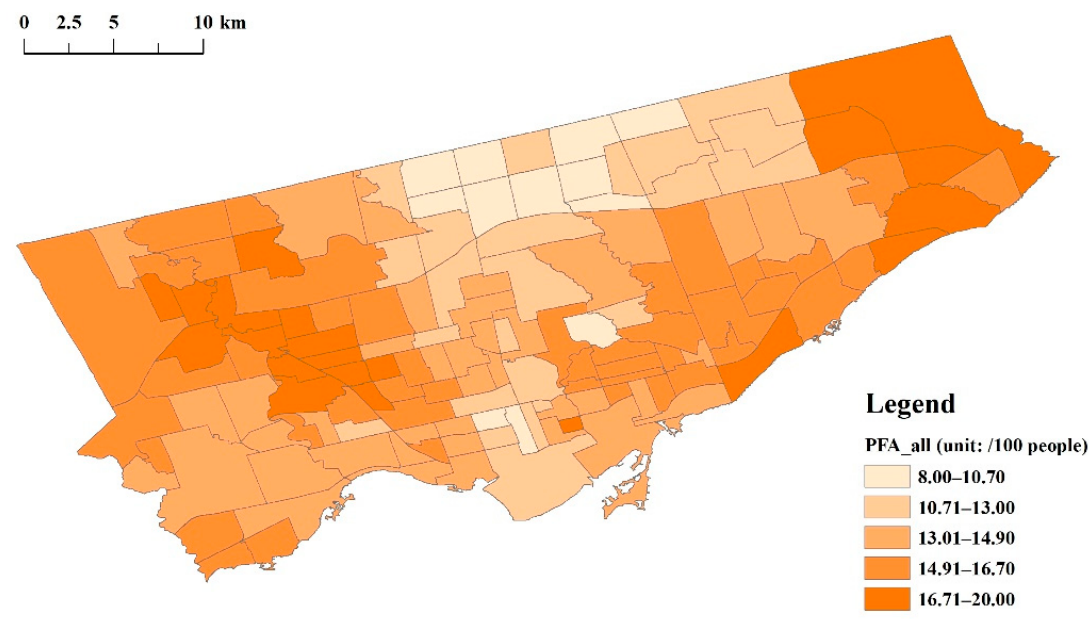
Figure A1. Distribution of the prevalence of female asthmatics at all ages (PFA_all).